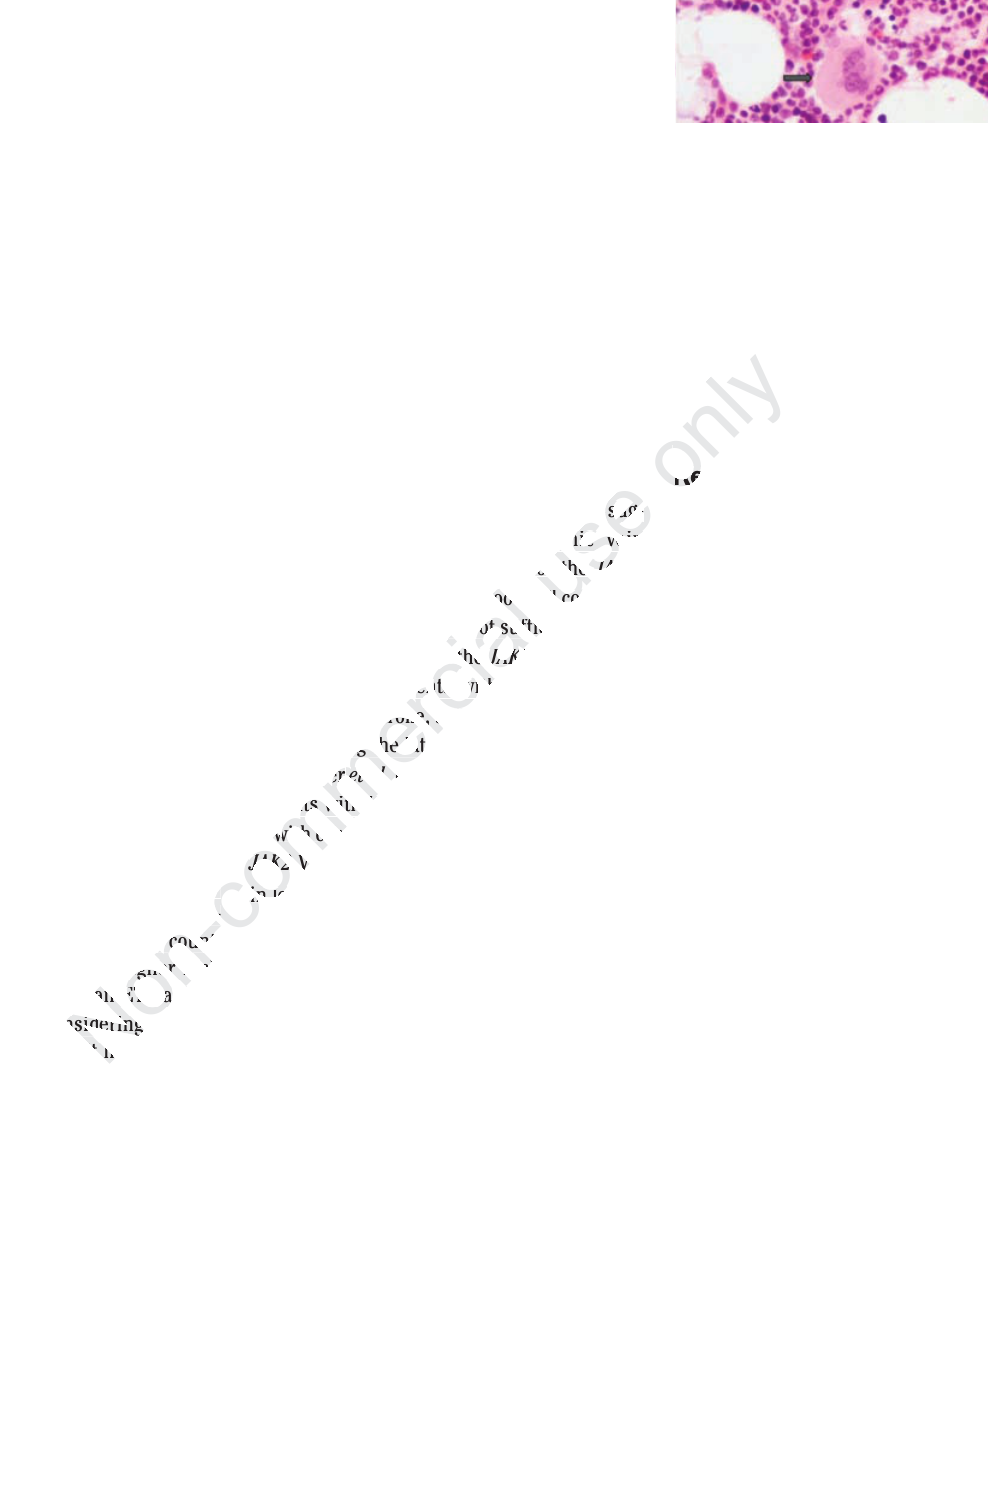
Figure 2. Histological section from bone marrow trephine shows trilineage hemo- poiesis including megakaryocytes (indicat- ed by arrows) with atypical nuclear mor- phology and variation in their size (Hematoxylin and Eosin stain, original magnification ¥ 40).